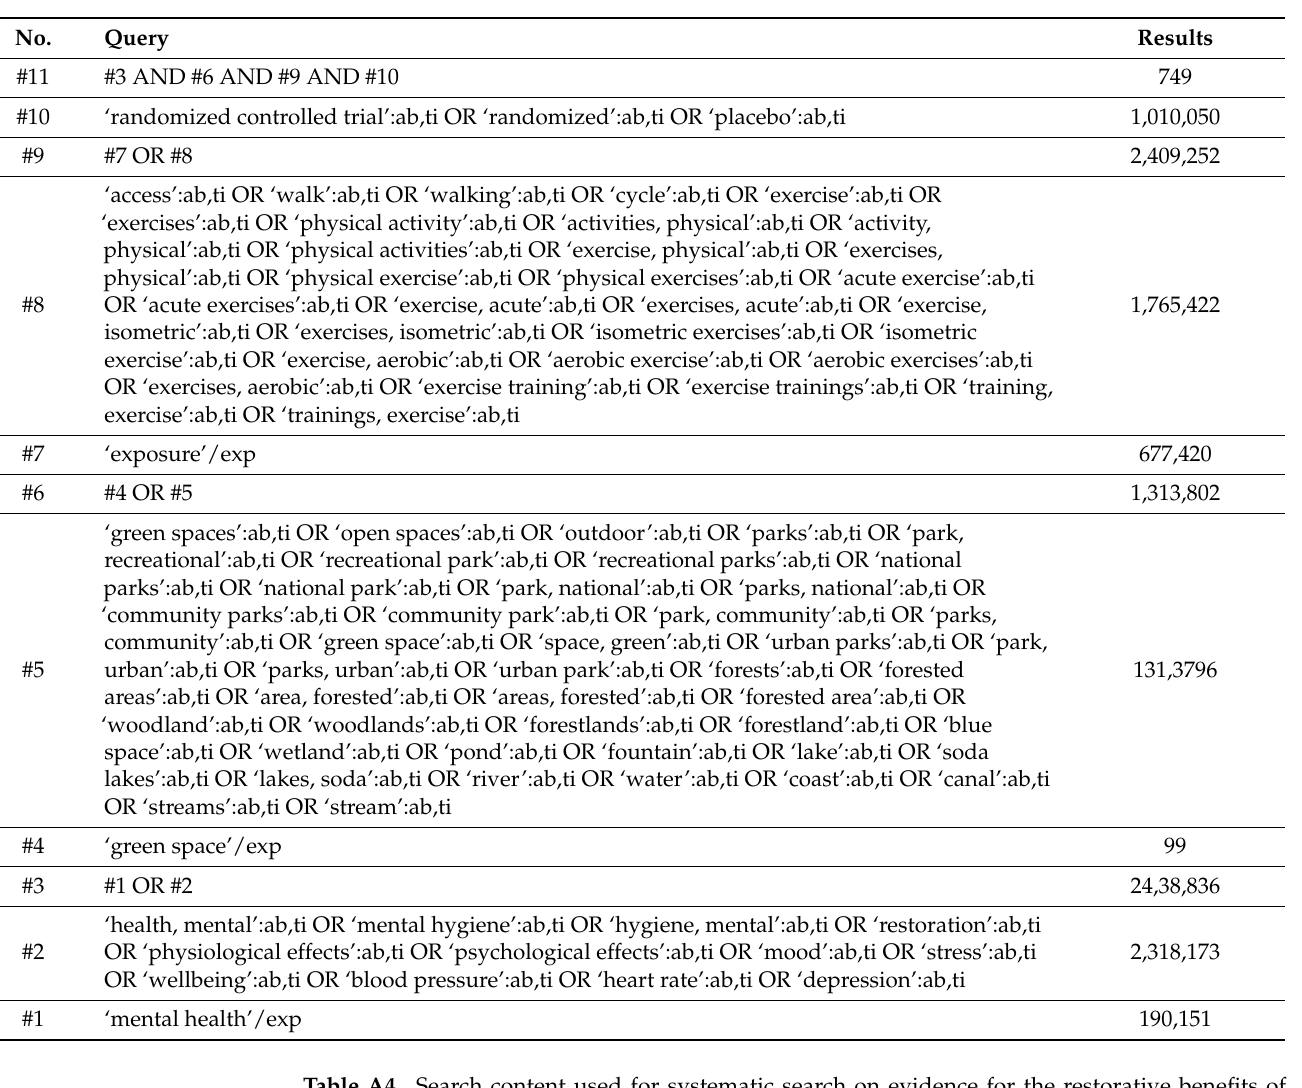
Table A4. Search content used for systematic search on evidence for the restorative benefits of exposure to green spaces on Scopus database (updated on 6 December